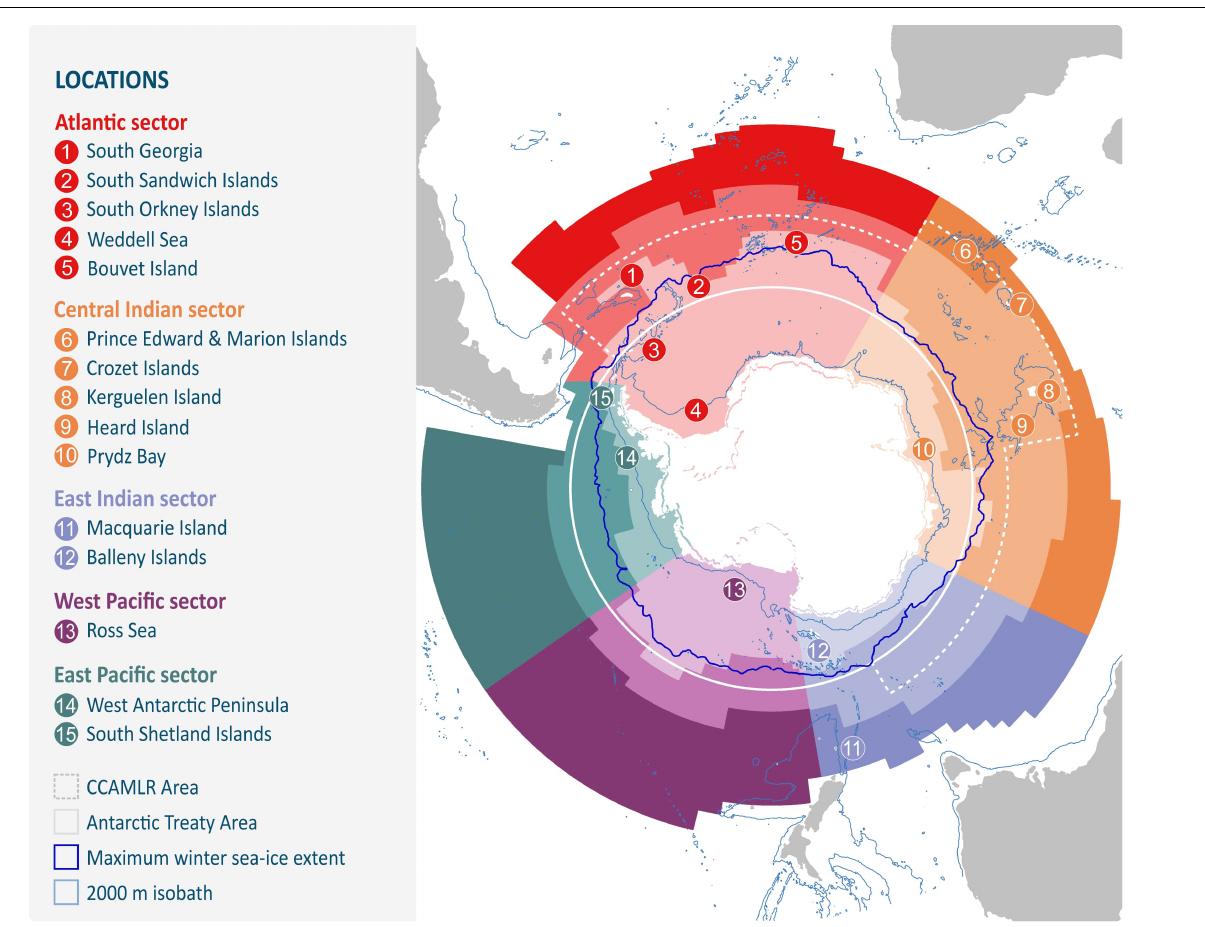
FIGURE 1 | Boundaries for the Marine Ecosystem Assessment for the Southern Ocean (MEASO) areas including five ocean sectors (Atlantic, Central Indian, East Indian, West Pacific, and East Pacific) each with three zone divisions. Sectors are divided meridionally. Zones extend from the coast to the Southern Antarctic Circumpolar Current Front (Antarctic Zone), to the Subantarctic Front (Subantarctic Zone) and to the Subtropical Front (Northern Zone). Islands are marked in white. Antarctica includes ice shelves. Antarctic Treaty is denoted by the solid white line and the area of the Convention on the Conservation of Antarctic Marine Living Resources is shown with a dashed line, which approximately follows the Antarctic Polar Front. The 2,000 m isobath is shown in light blue with the approximate position of the maximum winter sea ice extent shown in dark blue. Numbers refer to locations mentioned throughout the manuscript or with relevance to food web studies and correspond to those listed in the